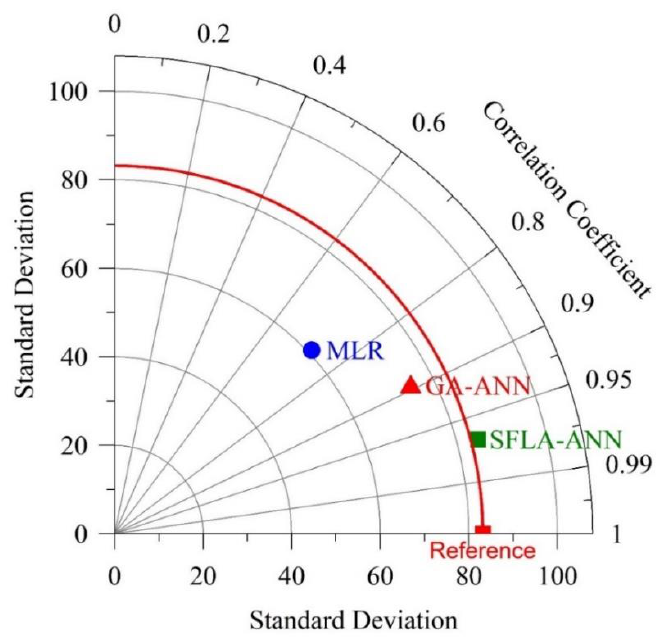
Figure 10. Taylor Diagram visualization of the SFLA-ANN model’s performance in predicting compressive strength.